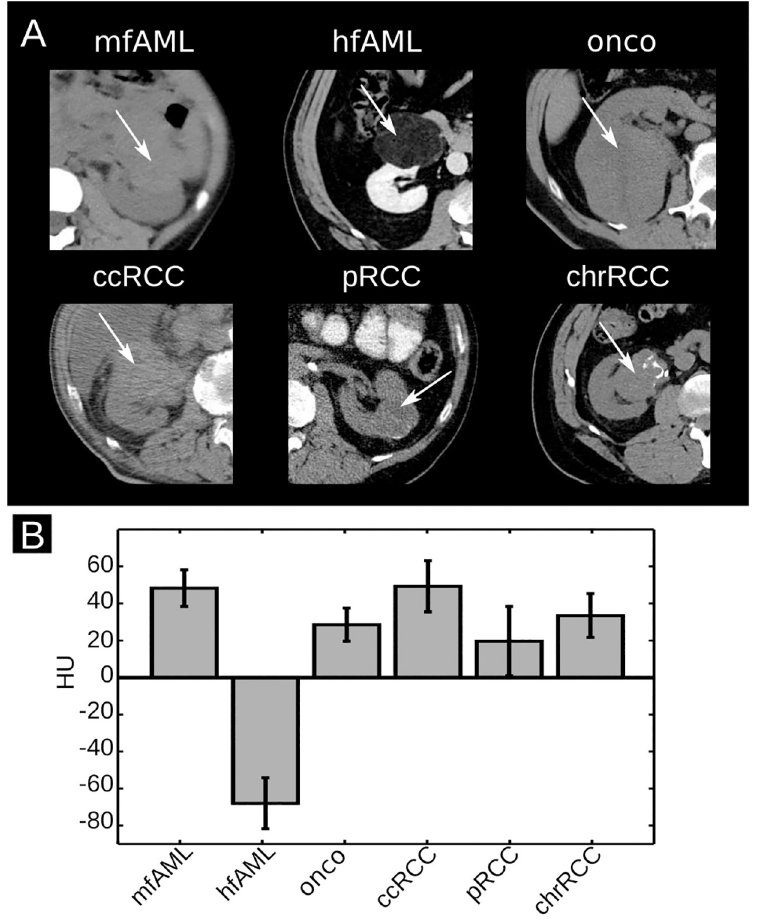
Fig 1. Clinical renal CT slices and distribution of HU values. (A) Representative clinical axial CT slices of kidney lesion samples in soft tissue window. Aside from the hfAML (venous phase CT) all other scans are unenhanced. The arrows highlight the tumorous tissue. (B) Mean and standard deviation of the quantitative HU values from the images presented in (A). HU: Hounsfield units, mfAML: minimal-fat angiomyolipoma, hfAML: high-fat angiomyolipoma, onco: oncocytoma, ccRCC: clear cell renal cell carcinoma pRCC: papillary renal cell carcinoma, chrRCC: chromophobe renal cell carcinoma.